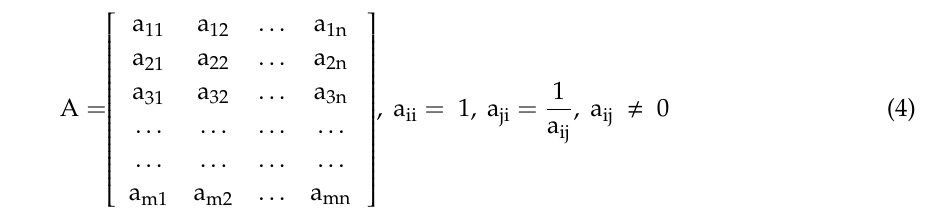
Table 3. The importance of indicators in pairwise comparisons based on the analytical hierarchy process (AHP) model [41]. Intensity of Importance Degree of Preference 1 Equally important 3 Moderately more important 5 Strongly more important 7 Very Strongly more important 9 Extremely more importance 2, 4, 6, 8 Intermediate values